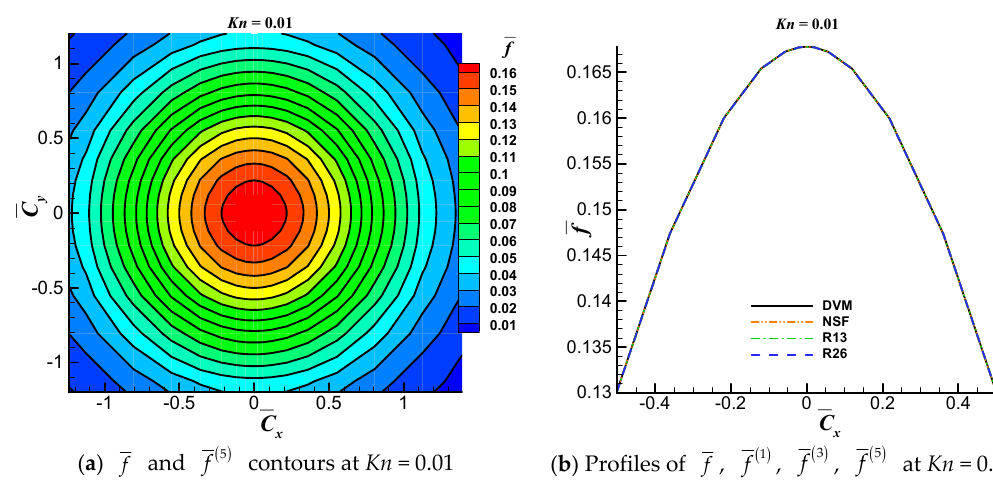
( 1 ) ( 3 ) ( 5 ) , f , and f at Kn = 0.01. The notations